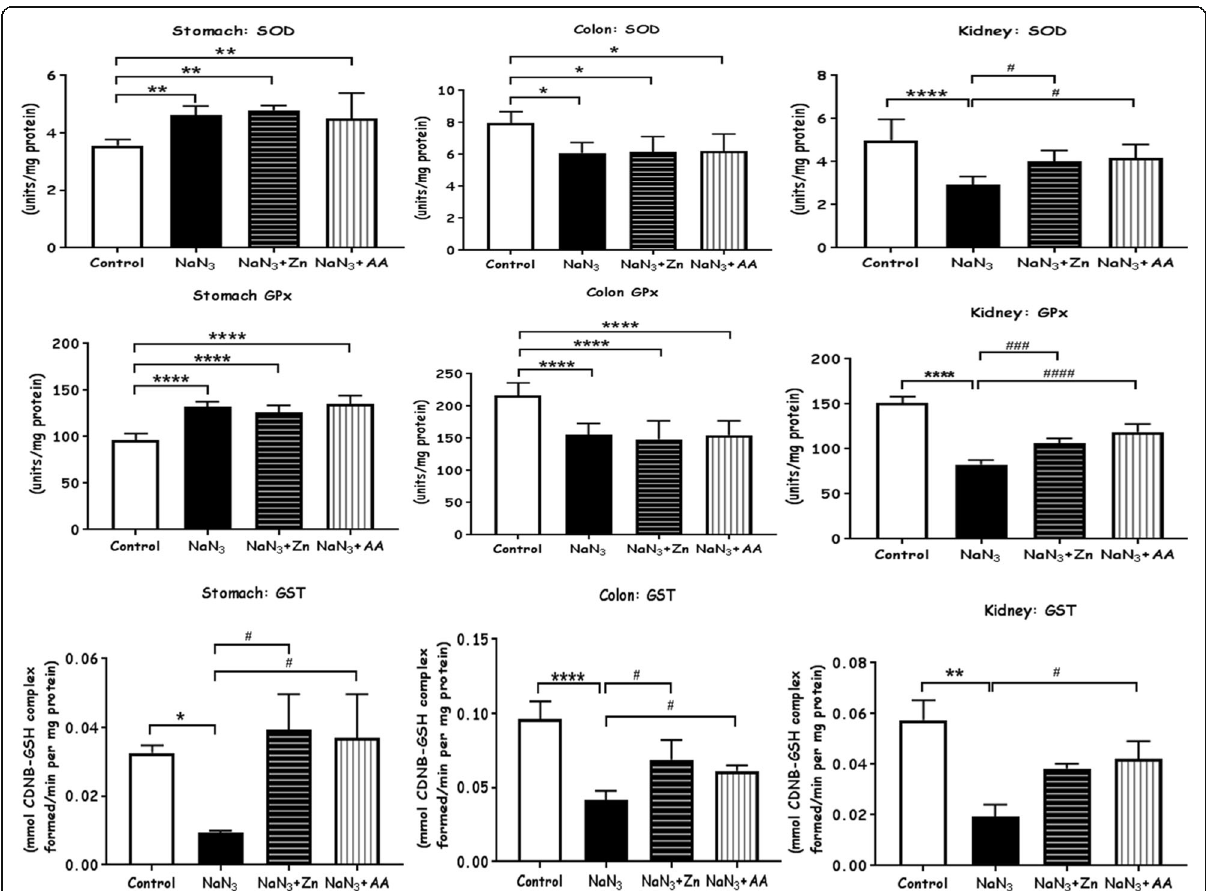
Fig. 3 The effects of Zn sulphate (Zn) and AsA (AA) on the activities of superoxide dismutase (SOD), glutathione peroxidase (GPx) and glutathione S-transferase (GST) in stomach, colon and kidney of rats treated with sodium azide (NaN 3 ). Values are given as mean ± standard deviation ( n = 7). Significant differences: *NaN 3 ; NaN 3 + Zn; NaN 3 + AA versus control group (* p < 0.05; ** p < 0.01; *** p < 0.001; **** p < 0.0001). # NaN # p < 0.05; ## p < 0.01; ### p < 0.001; #### p < 3 + Zn; NaN 3 + AA versus NaN 3 group (